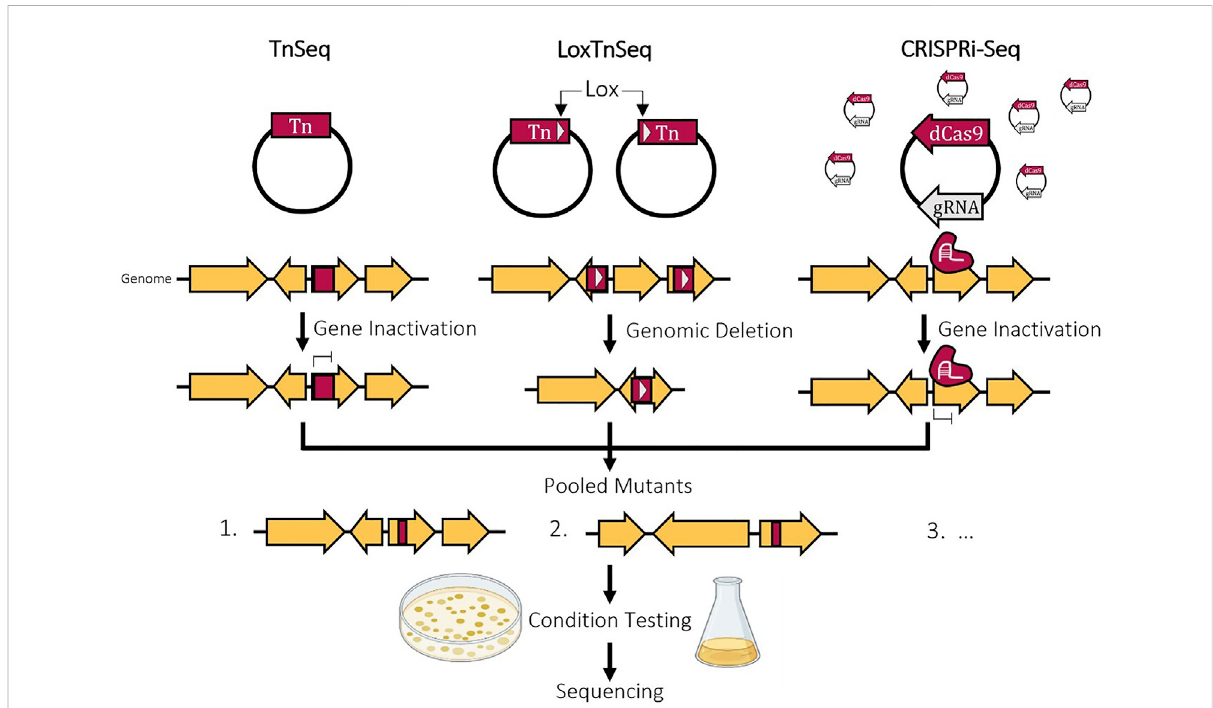
FIGURE 1 Schematic diagram of the construction of a reduced genome cell. Identi fi cation of essential genes using experimental and computational methods, genomic reduction by a top-down gene deletion or bottom-up synthesis approach, and evaluation of modi fi cations of this